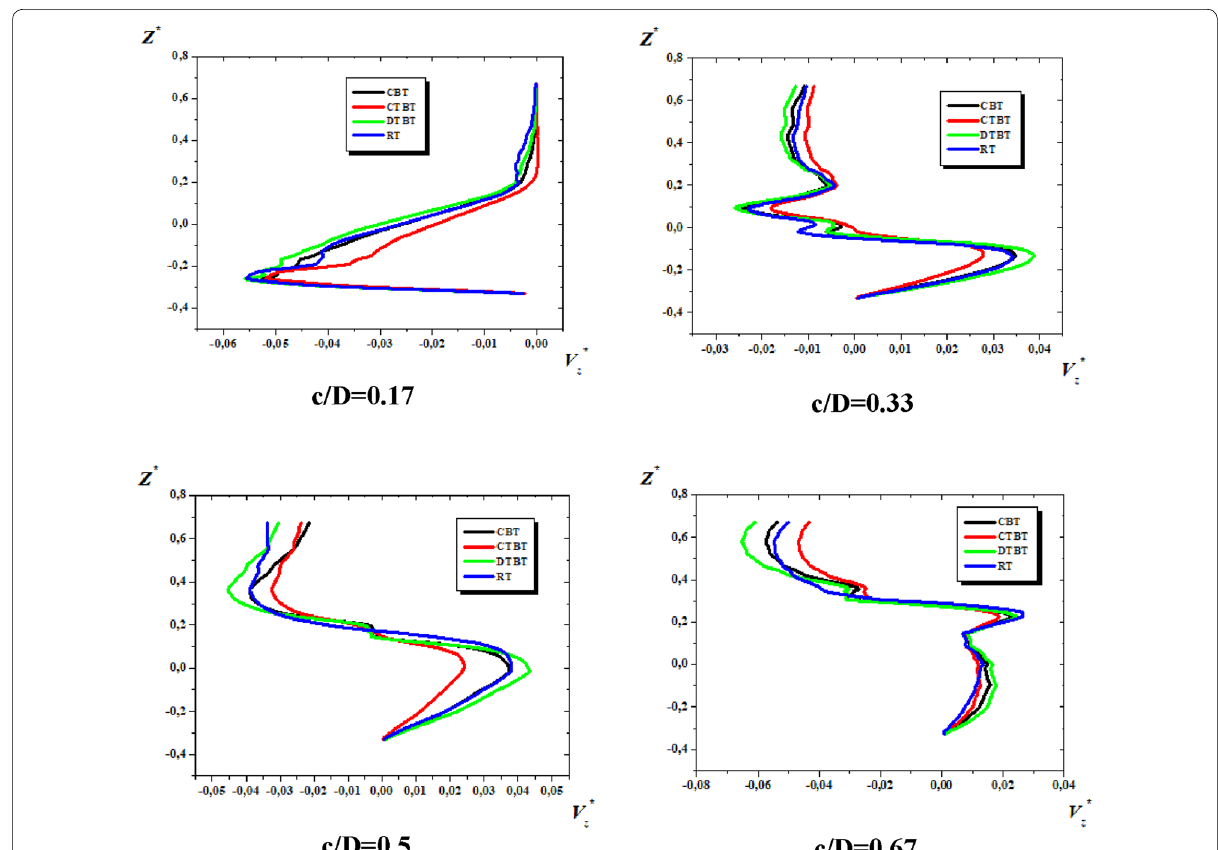
Figure 24 Axial velocities for different agitator’s types with impeller clearances along the vessel radius, at R *